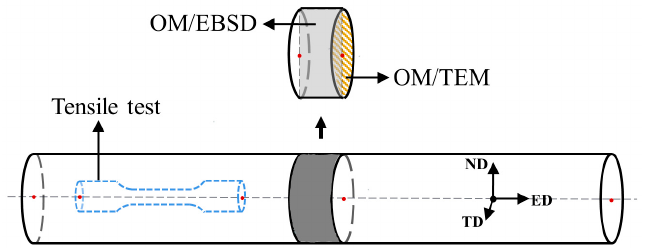
Figure 1. Schematic location of microstructure observation and tensile specimens.